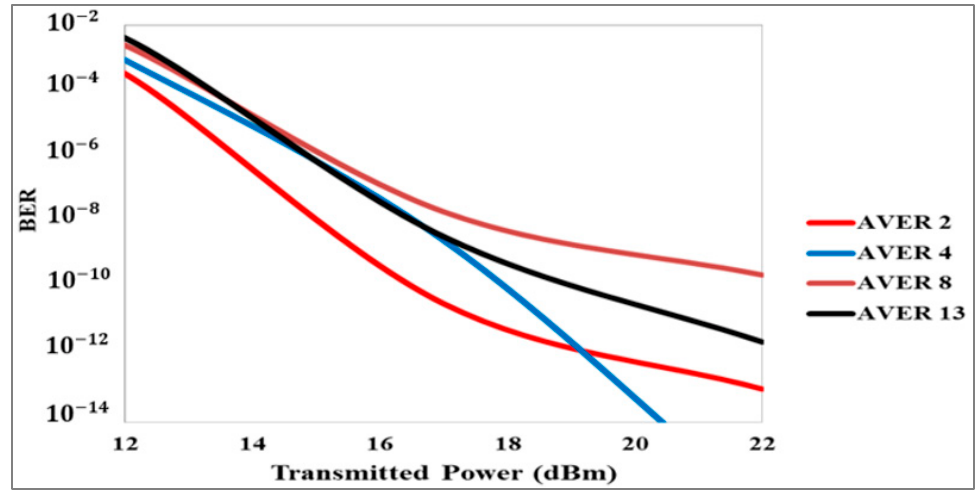
Figure 4. The Average BERs versus Transmitted Power for Four Random Channels (RZ).